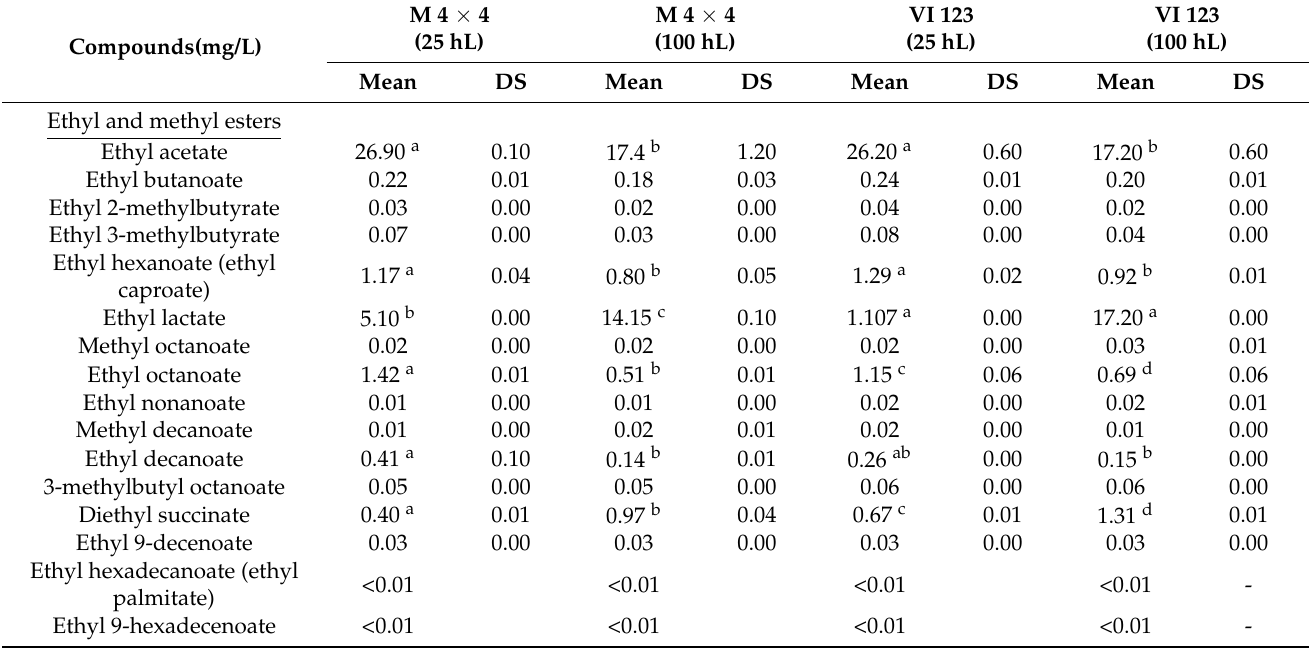
Figure 6. Chemical and microbiological monitoring of the wine fermentations obtained inoculating the indigenous S. cerevisiae strain VI-123 ( a ), produced using the plant, and the commercial starter BM4 × 4 ( b ) in 100 hL of grape must. Table 4. SPE/GC-MS analysis of the wines obtained from 25 and 100 hL fermentations inoculated by the indigenous S. cerevisiae strain VI-123 (produced using the plant) and the commercial starter BM4 × 4. Different letters indicate significant different concentrations between strains (ANOVA, p <